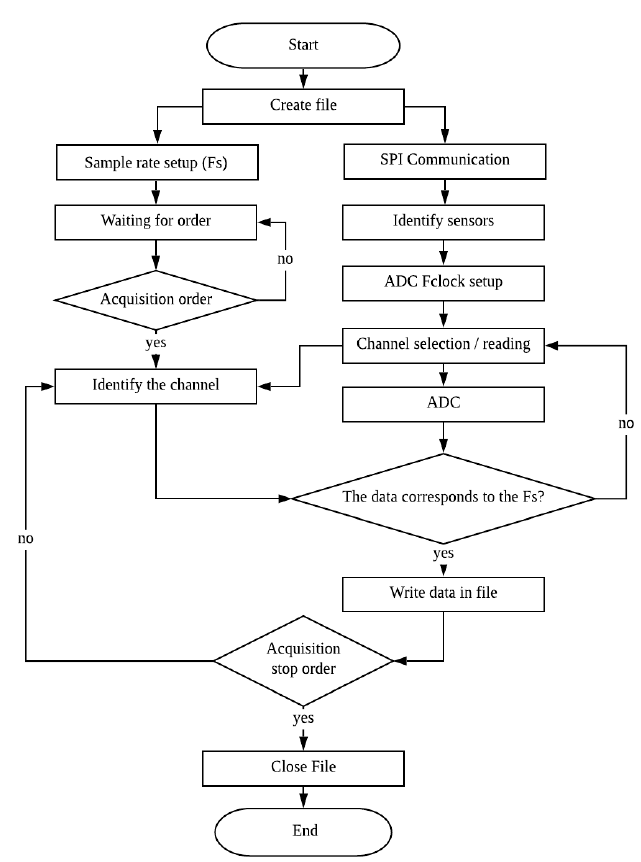
Figure 3. The data acquisition system operational flow chart.